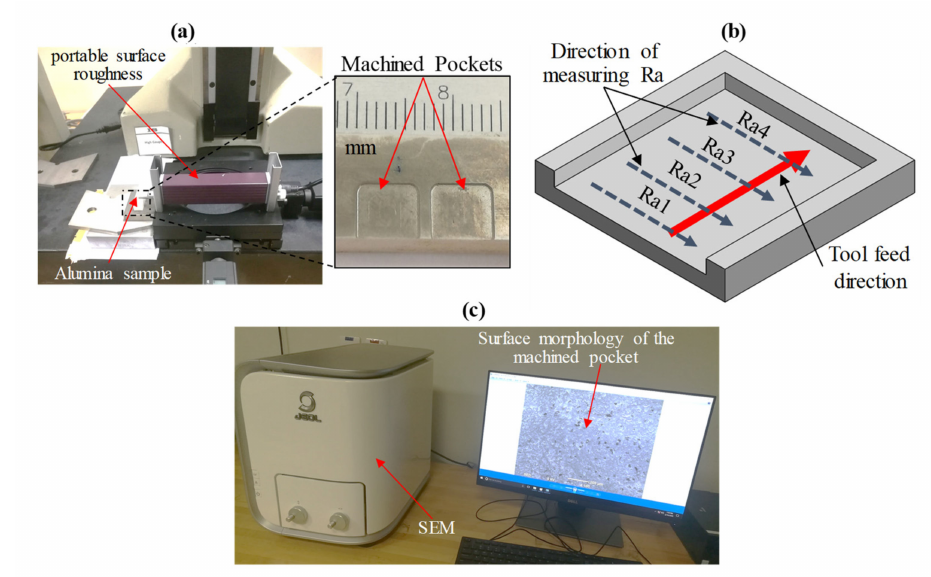
Figure 3. ( a ) Set up of measuring Ra, ( b ) schematic of measuring the surface roughness (Ra), and ( c ) surface morphology measuring set